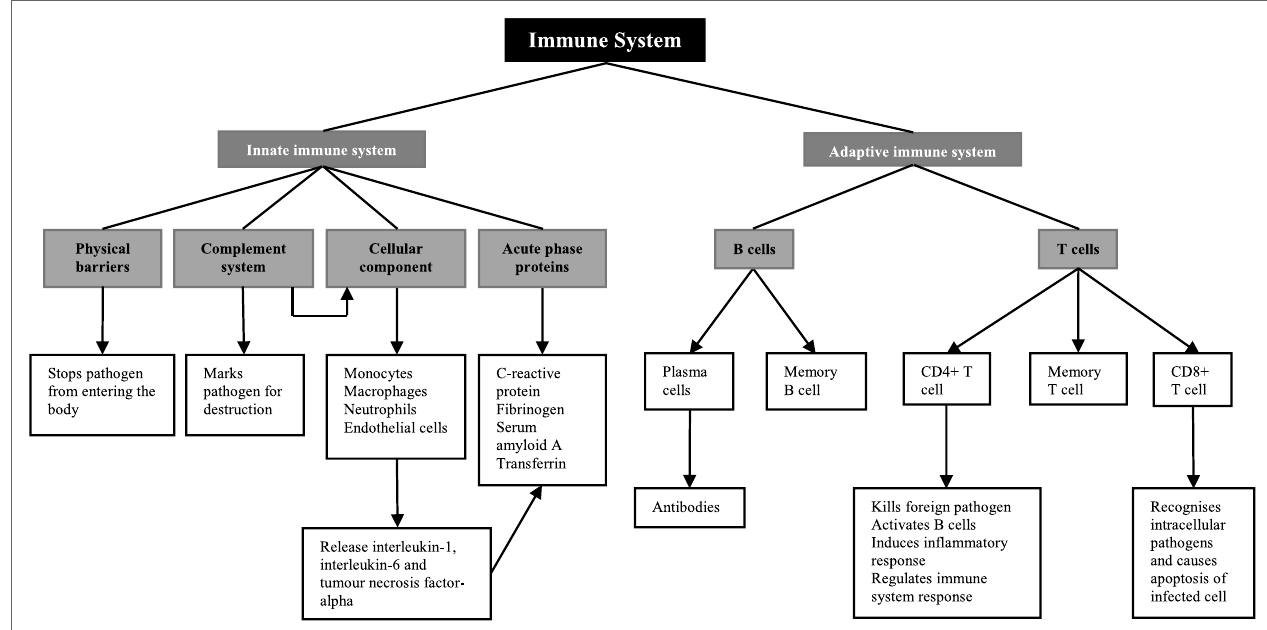
FiGURe 1 | Overview of the immune